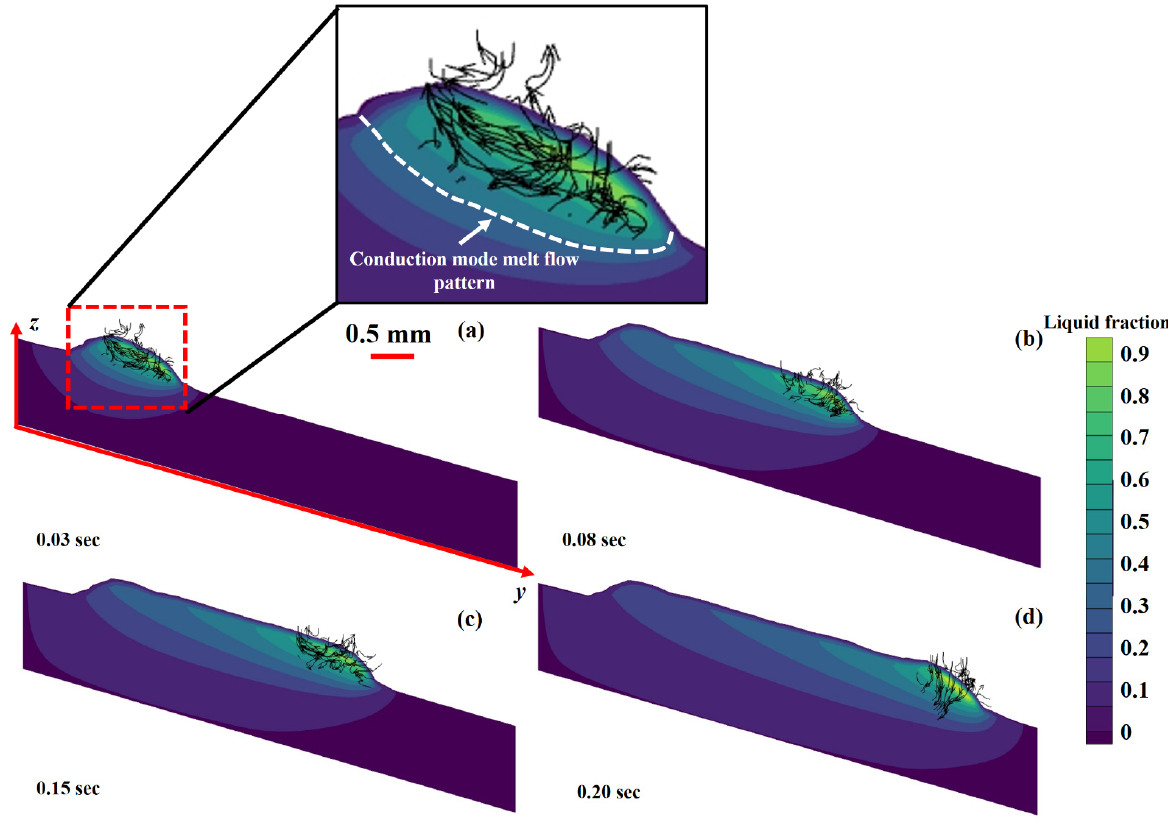
Figure 4. Section view of the LMD deposited layer from the top view in the case of Ti6Al4V material at various intervals: ( a ) 0.03 s, ( b ) 0.08 s, ( c ) 0.15 s and ( d ) 0.20 s. Figure 5a–d compiles the evolution of thermal distribution during the printing of Ti6Al4V layer on Ti6Al4V substrate. During LMD additive manufacturing, a 1900 K tem- perature was achieved. During deposition, the material temperature dropped from melt- ing to ambient temperature due to the printed layer's heat losses, resulting in layer depo- sition. It is essential to emphasize that the extreme layer area is in contact with ambient air, which is responsible for the heat elimination from the deposited layer’s top.